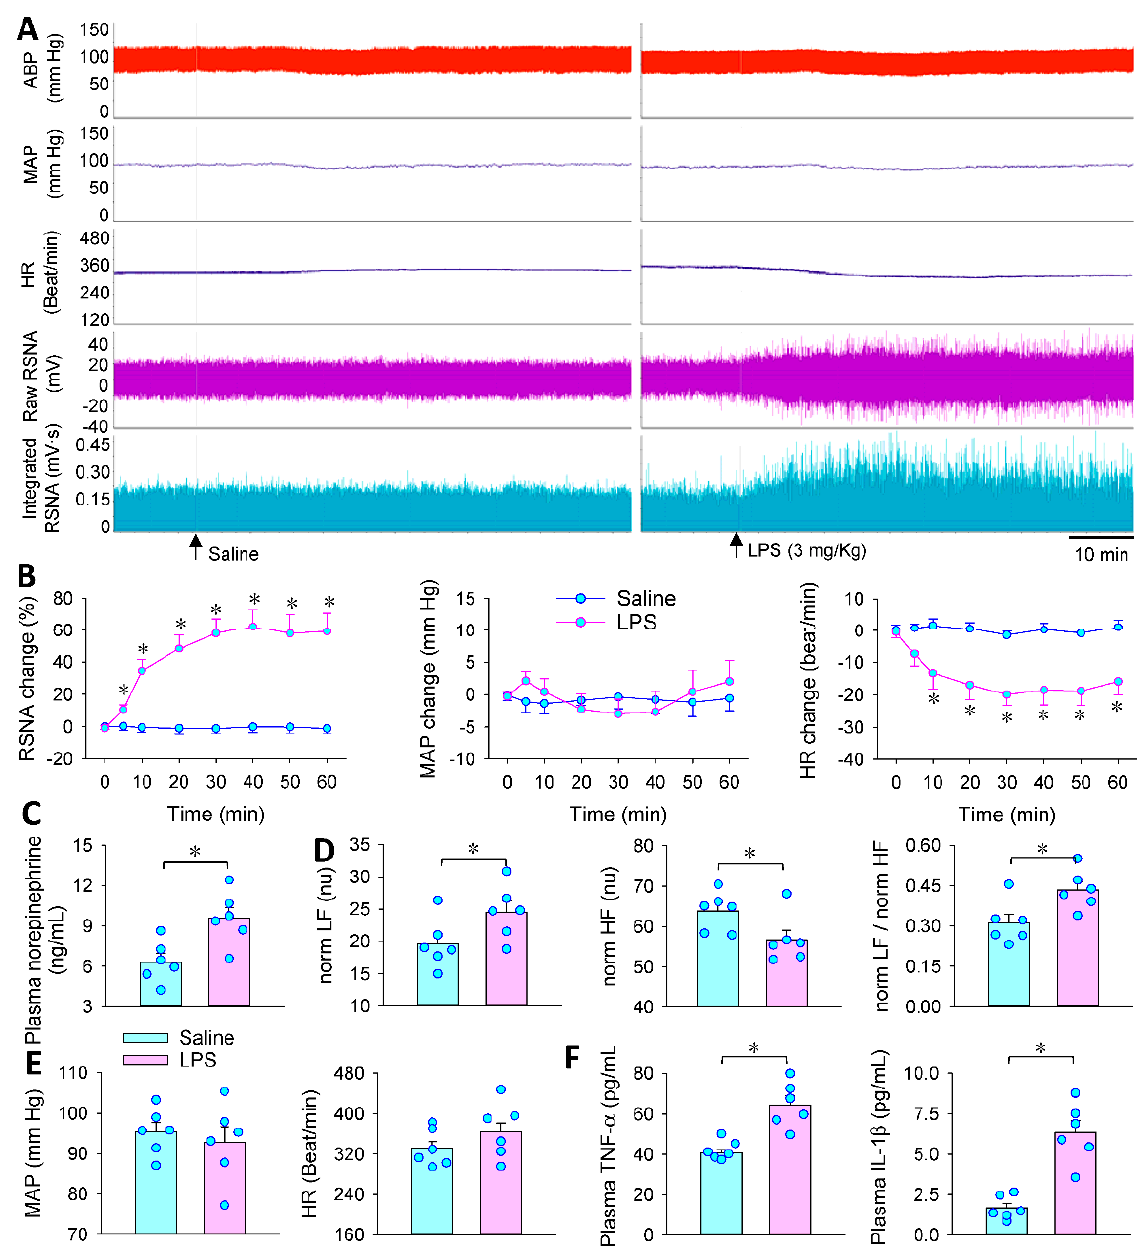
Figure 1. Effects of lipopolysaccharide (LPS) on RSNA, MAP and HR in rats. Rat was subjected to intraperitoneal injection of LPS (3 mg/Kg body weight). ( A , B ) LPS-induced changes in renal sympathetic nerve activity (RSNA), mean arterial pressure (MAP) and heart rate (HR) in the first hour after the LPS injection; ( C – E ) LPS-induced changes in plasma norepinephrine level, heart rate variability analyses, MAP and HR 24 h after the LPS injection; ( F ) LPS-induced changes in plasma TNF- α and IL-1 β levels 24 h after the LPS injection * p < 0.05. n = 6.